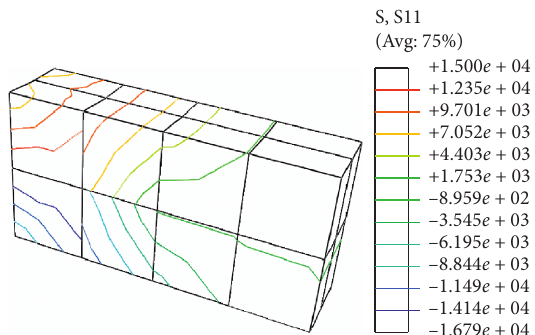
Figure 8: Axial stress distribution of the root. The unit of the legend is kPa.